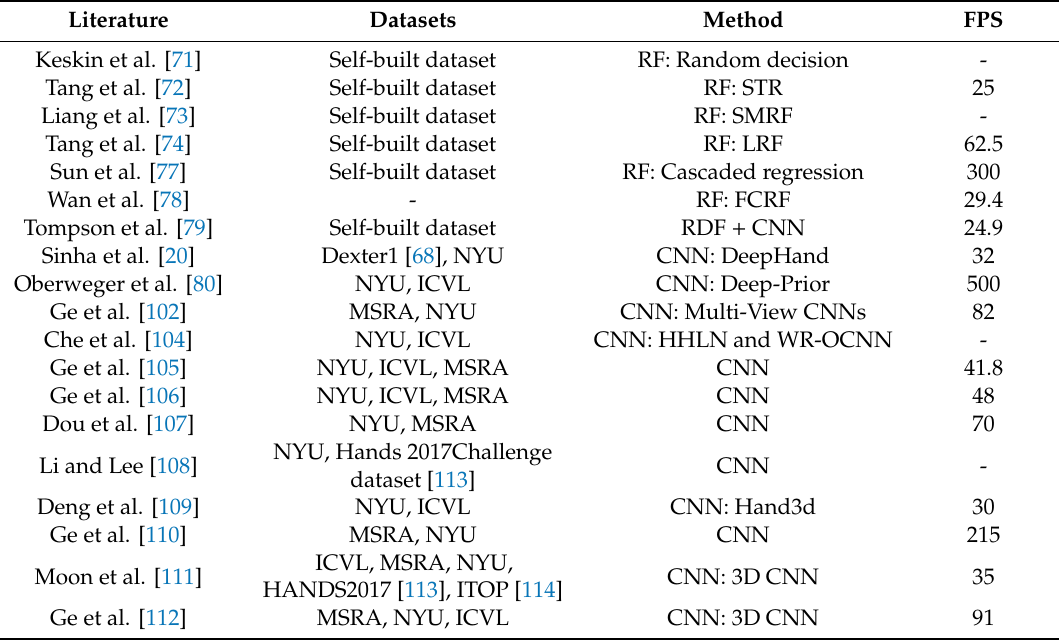
Table 4. Summary of discriminative methods for hand pose estimation with RGB and depth inputs.